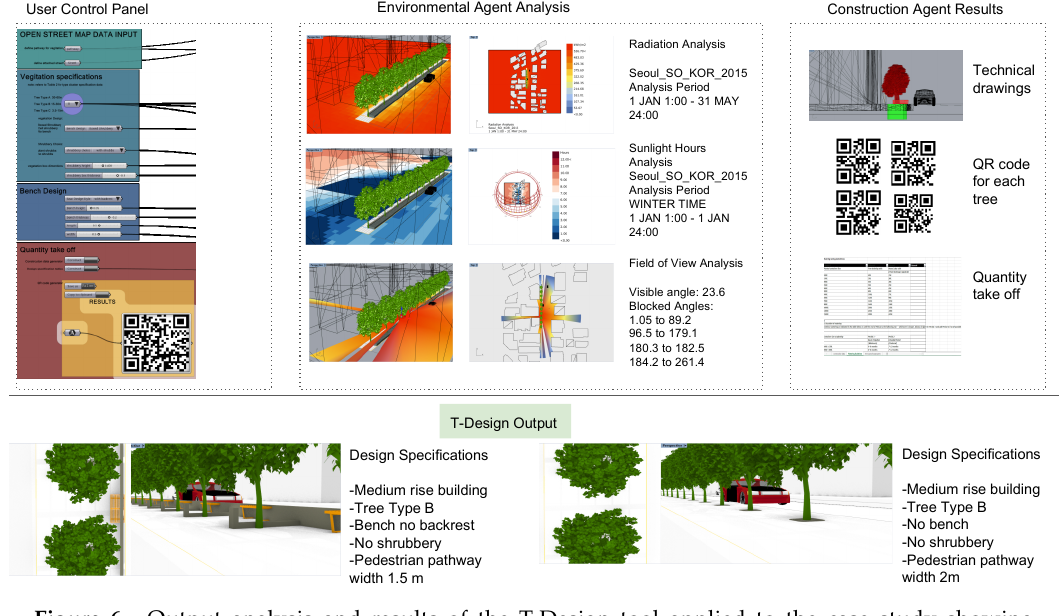
Figure 6. Output analysis and results of the T-Design tool applied to the case study showing the user control panel interface, environmental analysis, construction outputs and the visualized three-dimensional (3D) models of two different configurations.